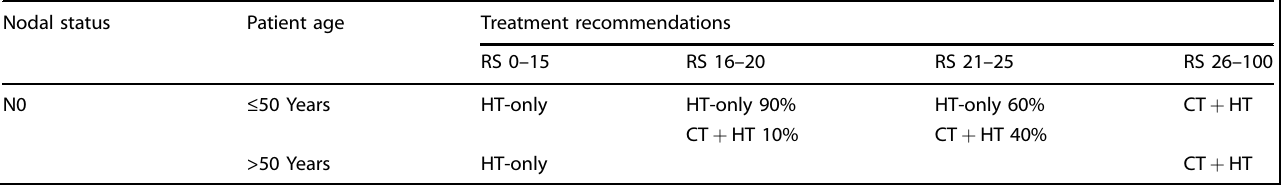
TABLE 4. Algorithm used to estimate distribution of post-RS treatment recommendations in N0 patients based on TAILORx results. Nodal